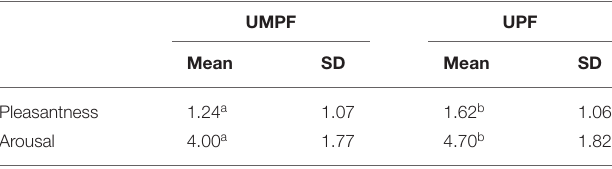
TABLE 1 | Mean pleasantness and arousal ratings for the pictures depicting UMPF and UPF.